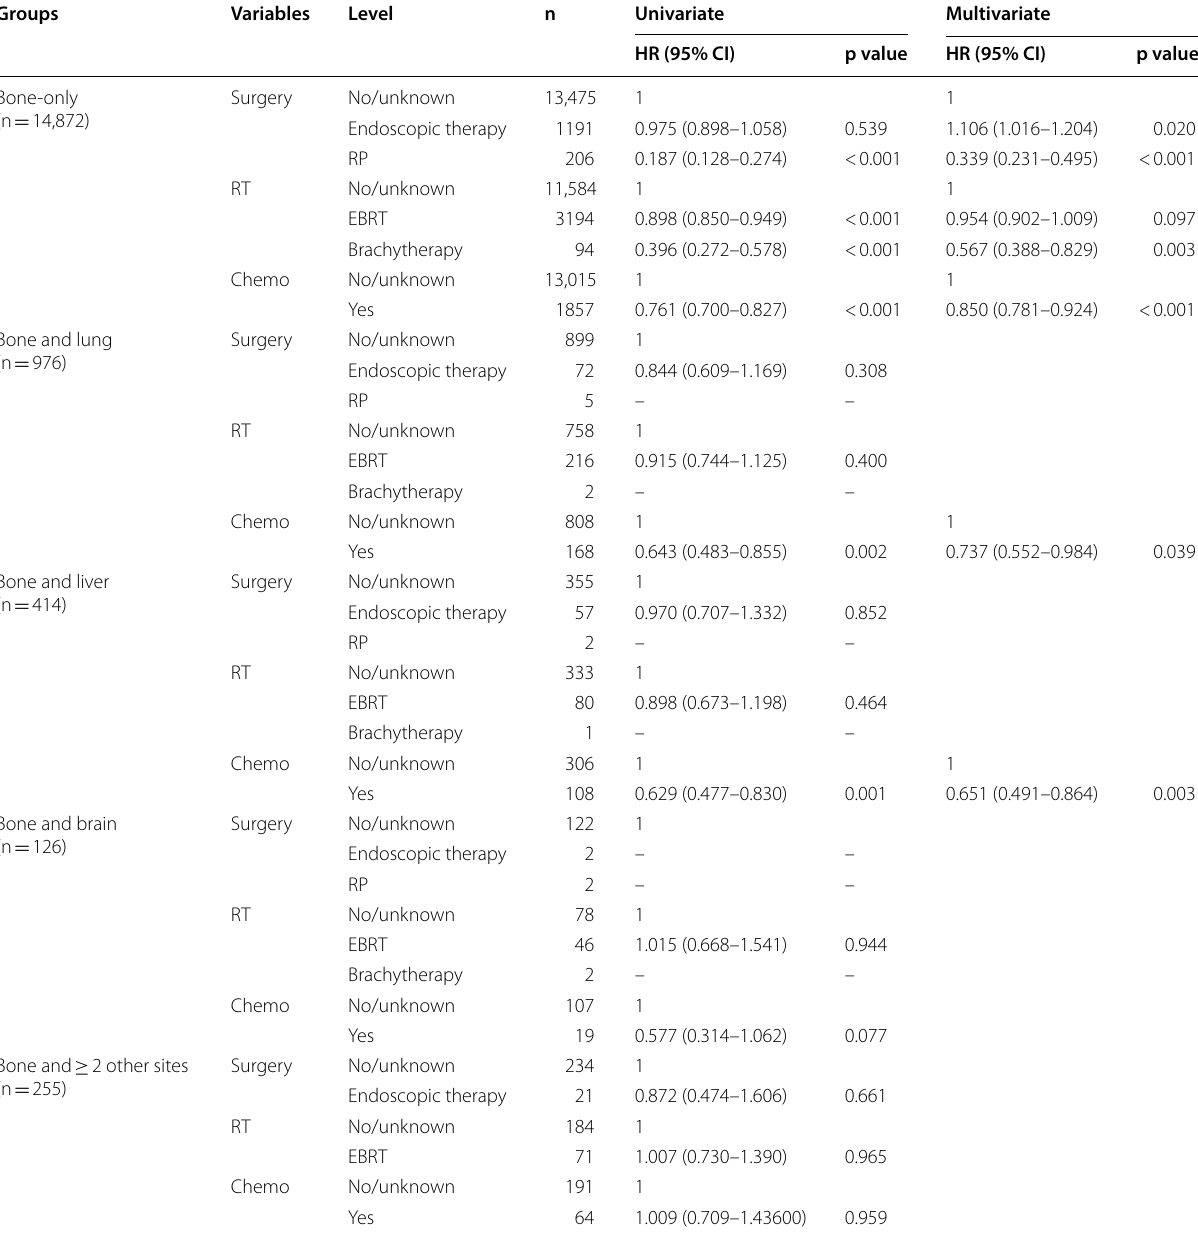
Table 3 Univariate and multivariate Cox regression for all-cause mortality based on treatment modalities and metastatic